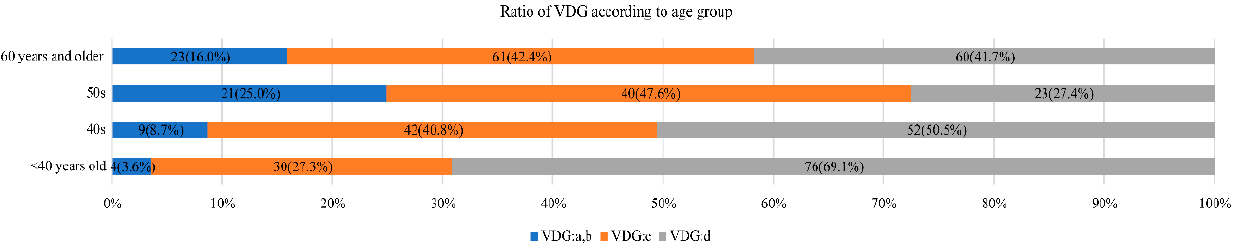
Figure 2. Volpara Density Grade (VDG) according to age.